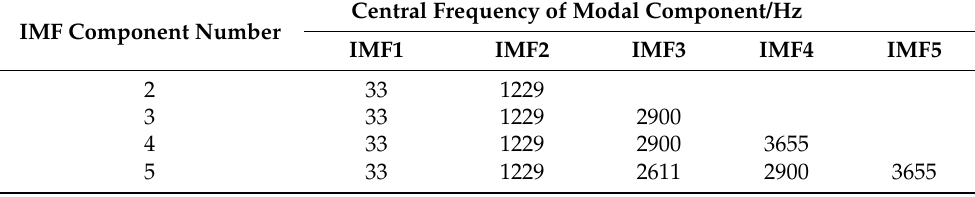
Table 3. The central frequencies of different IMF